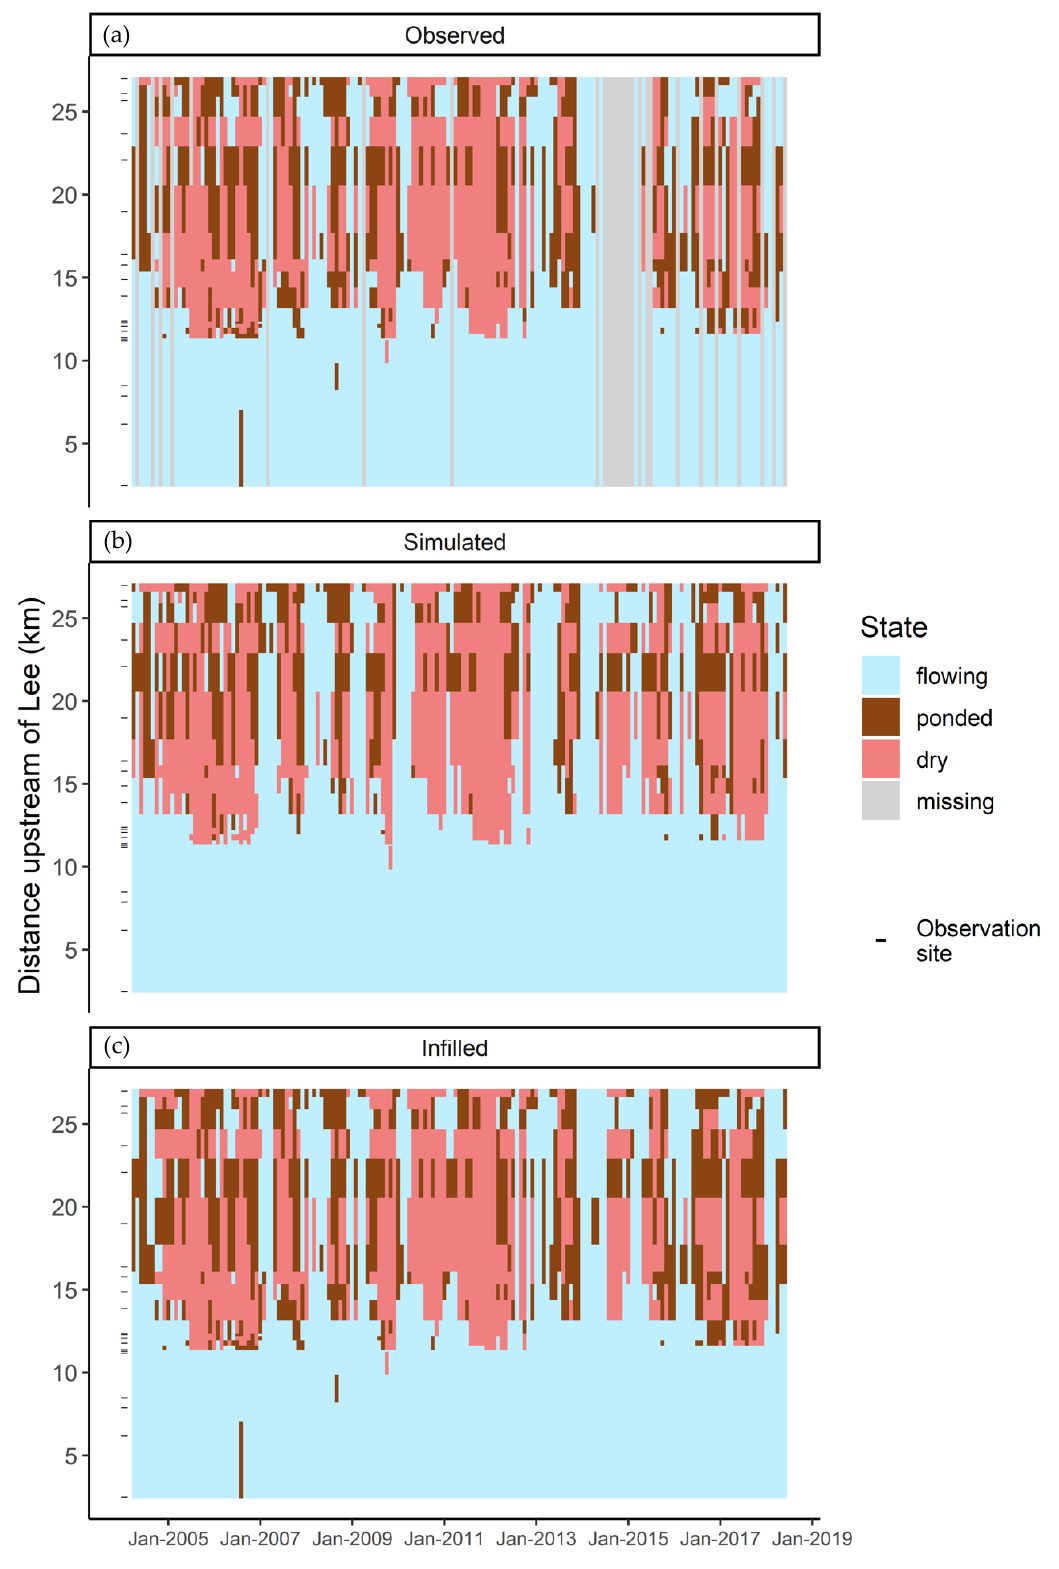
Figure 8. Monthly time series of observed ( a ), simulated ( b ), and infilled ( c ) hydrological state on the Ash, where infilled states are observations where available and simulations where observations are unavailable. Hydrological state is assumed to be consistent along observed reaches due to the high spatial resolution of the data.